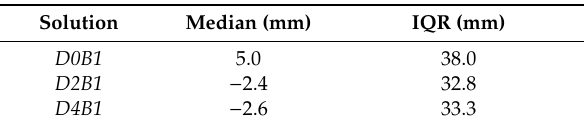
Table 5. Median and interquartile range (IQR) of SLR residuals with respect to GLONASS orbits between January 2012 and December 2014. The orbits were computed using three different orbit parametrizations, namely D0B1 , D4B1 , and D2B1 . The observations for eclipsing satellites (absolute value of solar beta angle smaller than 15°) and for SVN 721, 723, 725, 730, 736, and 737 satellites were excluded due to anomalous patterns [15,29].